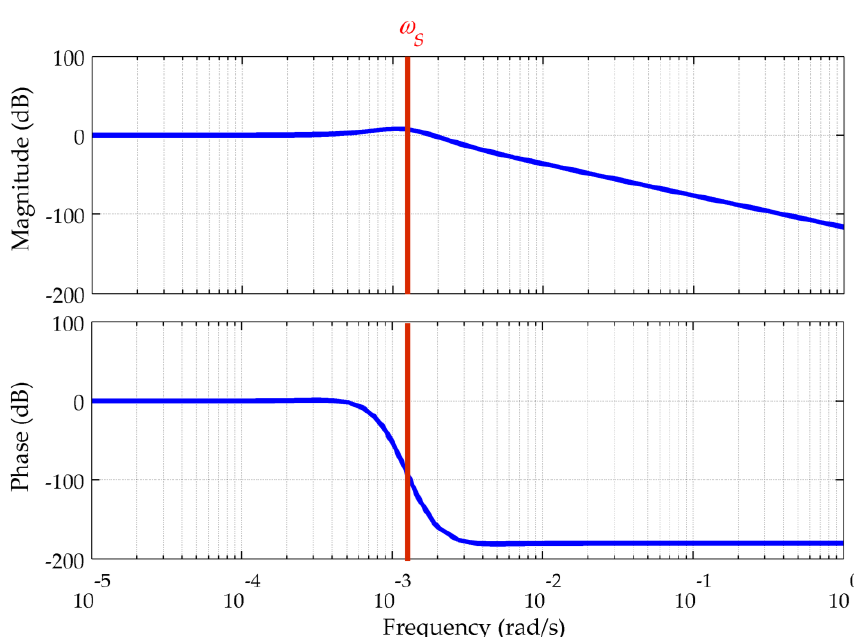
Figure 3. Bode plot of I ( s ) ( μ = 0.5, ζ = 1.296) .